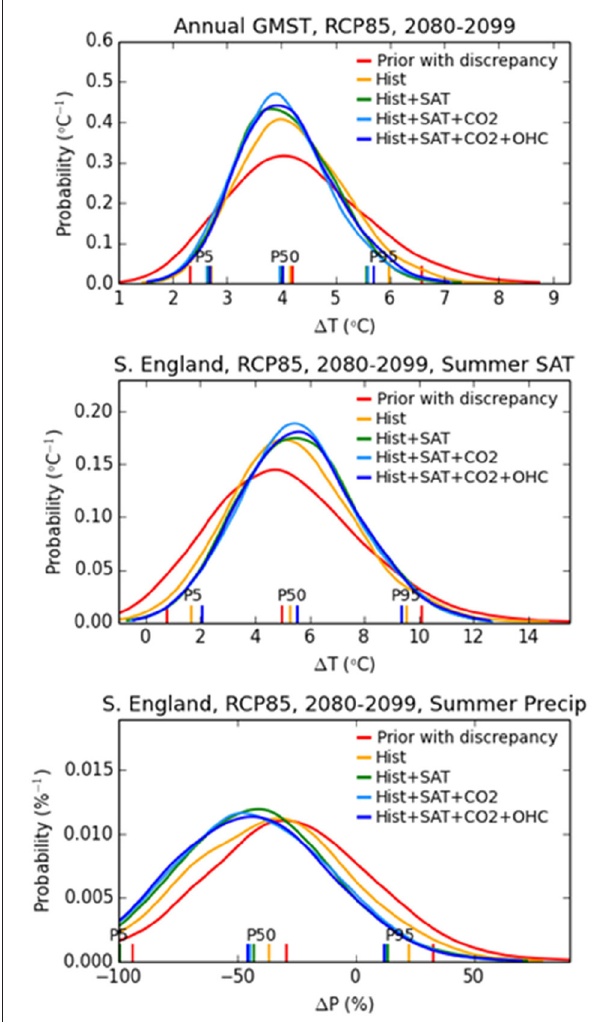
FIGURE 1 | Examples of the impact of constraints derived from historical climatology (Hist), added historical global surface air temperature trends (Hist + SAT), added historical trends in atmospheric CO 2 concentration (Hist + SAT + CO2), and added upper ocean heat content (Hist + SAT + CO2 + OHC), in modifying the prior distribution to form the posterior. The 5th, 50th (median), and 95th percentiles are plotted, along with the pdfs. Results prior to the application of observational constraints (Prior with discrepancy) are also shown. Reproduced from Murphy et al.